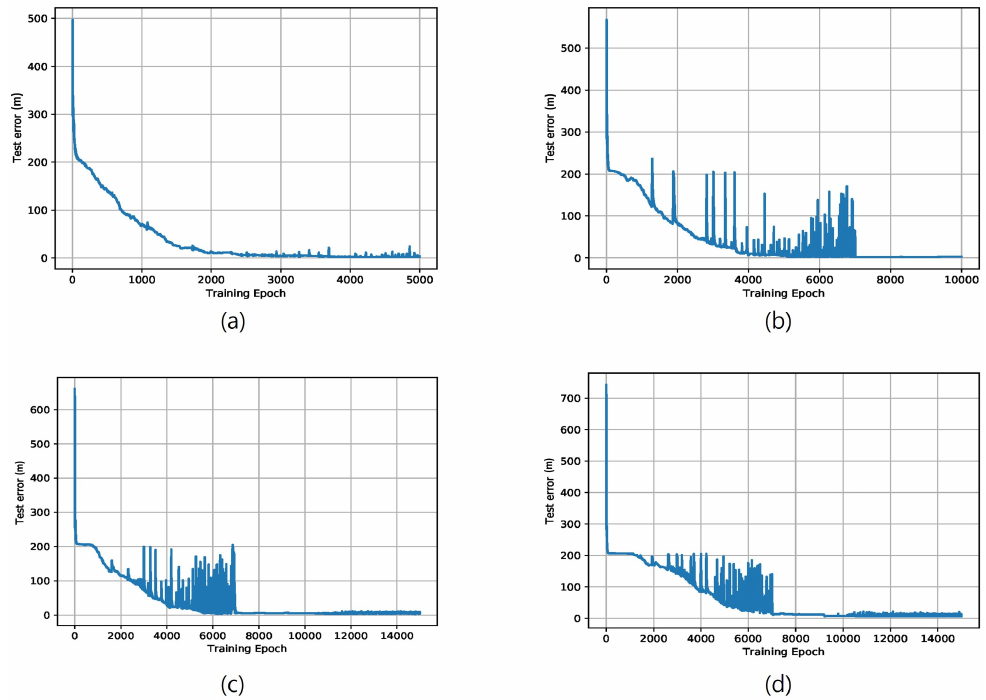
Figure 5. Positioning test error by deep neural network according to the number of estimated positions: ( a ) K = 10, ( b ) K = 15, ( c ) K = 20, ( d ) K =